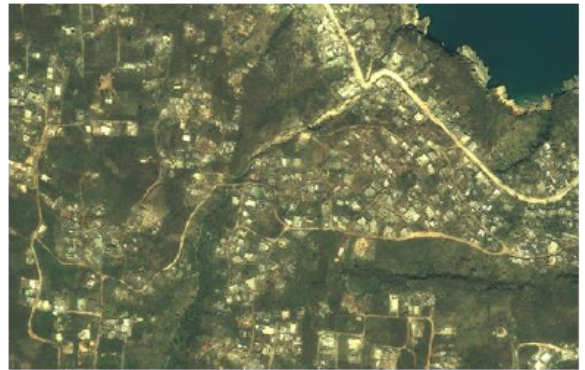
Figure 11. Haiti validation image 2 segmentation with a preliminary building segmentation (made only with the pre-disaster image). Several proposed